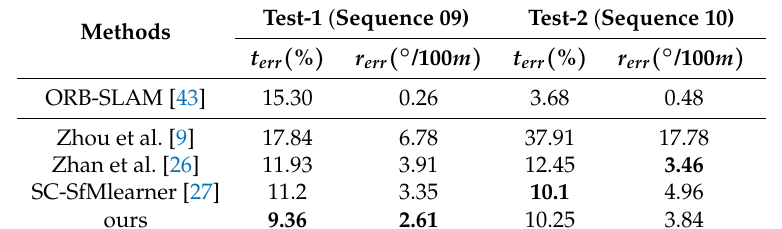
Table 2. The estimation results on KITTI odometry dataset. t err is average translational drift error. r err is average rotational drift error. The ORB-SLAM is a traditional visual SLAM method and is used as a reference. The best results for methods based on unsupervised learning is highlighted.